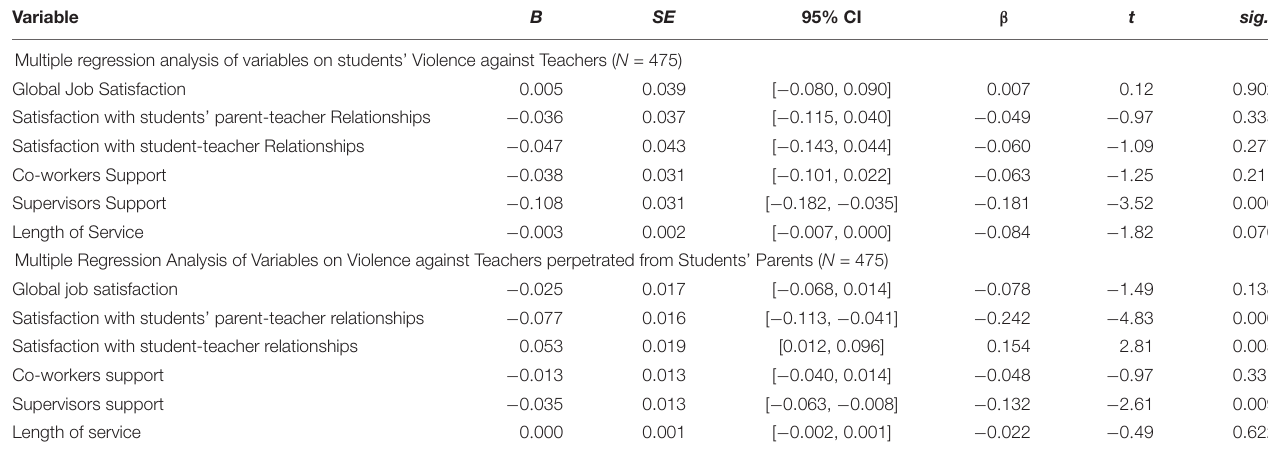
TABLE 3 | Multiple regression